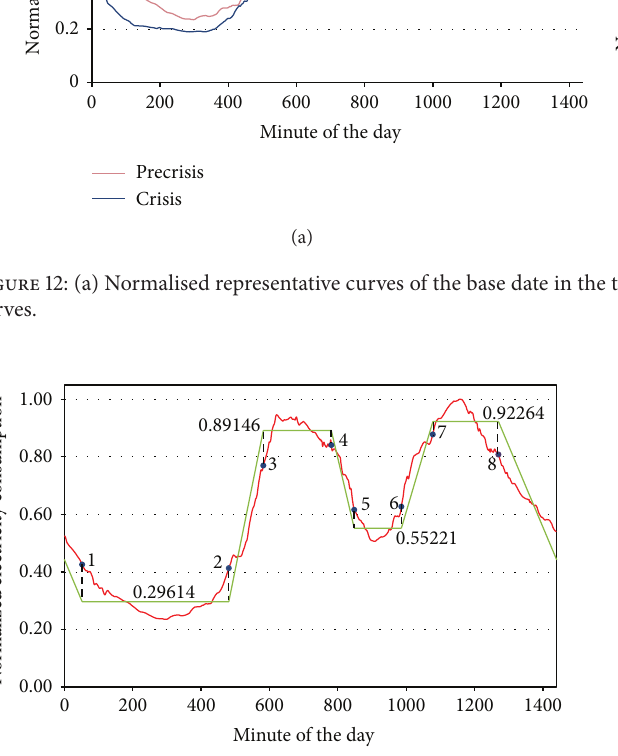
Figure 13: Linearization process of precrisis representative curve.